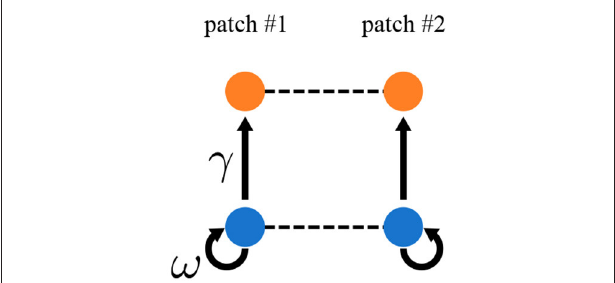
FIGURE 6 | Metacommunity model with spatial asymmetry in interaction strength. Interaction strength and biomass production by primary producers are γ and ω times higher, respectively, in patch #1 than in patch #2.